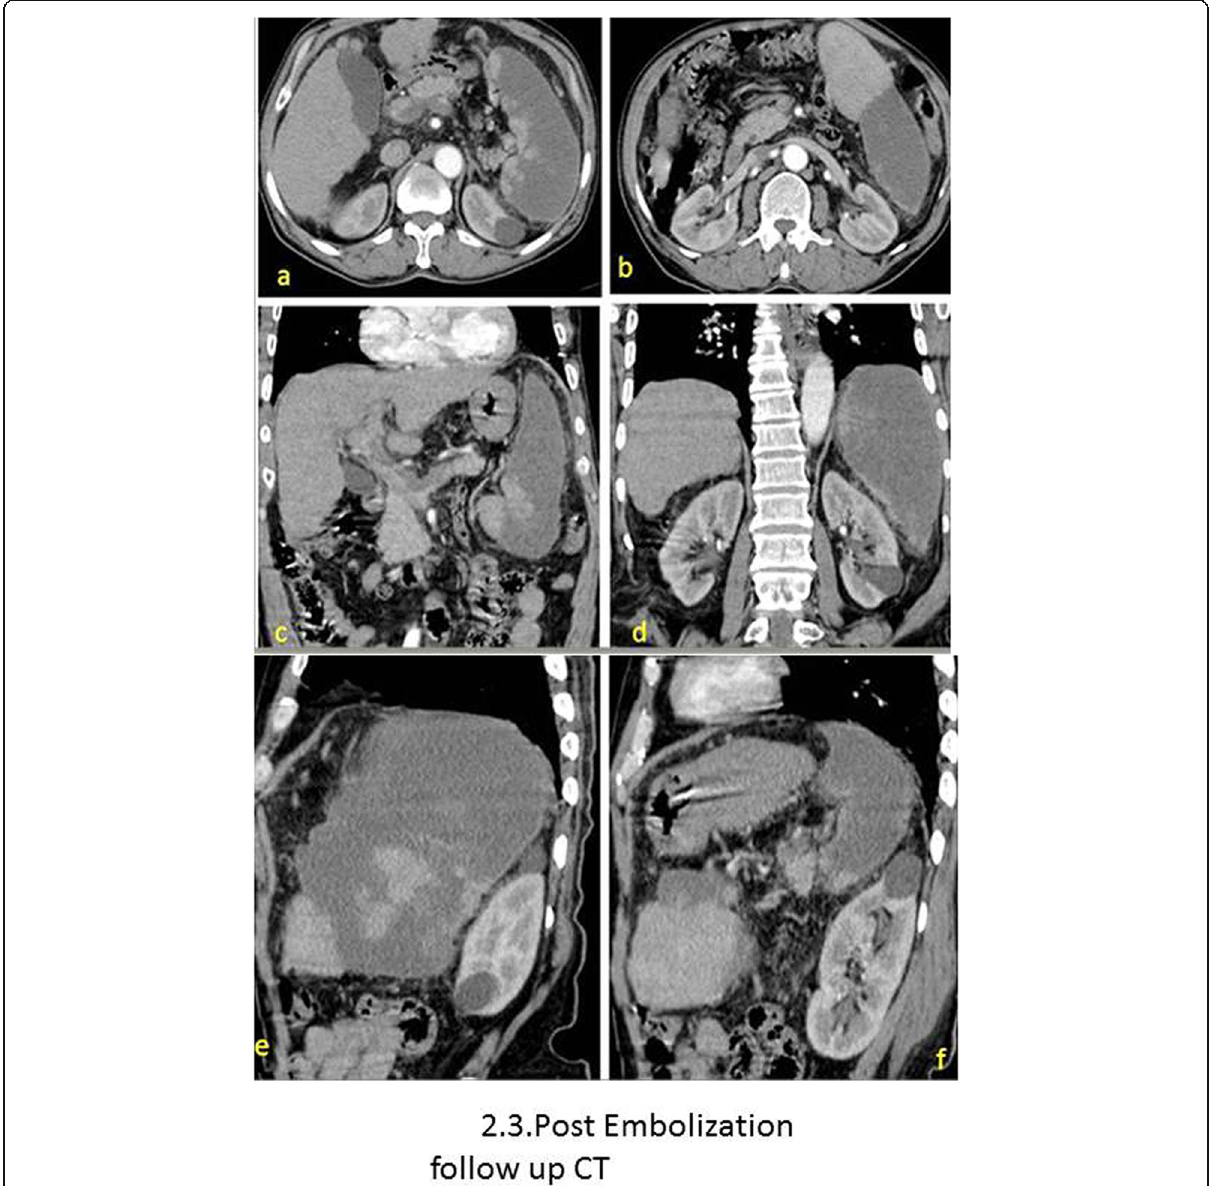
Fig. 4 Post-PSE. Follow-up abdominal CT examination (3 months) post-splenic embolization. a , b Axial images showing multiple hypodense non- enhanced areas of infarctions seen involving most of the splenic parenchyma with some areas spared. c – f Coronal and sagittal